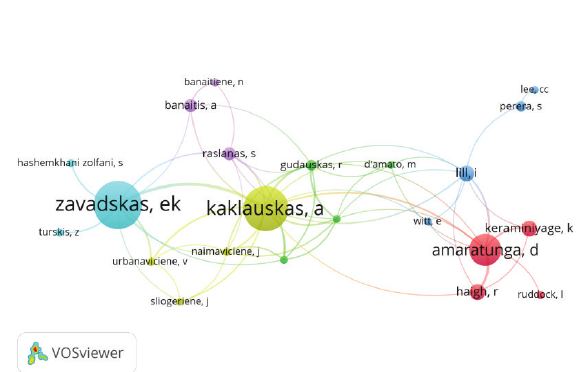
Figure 9. Author co-authorship network of